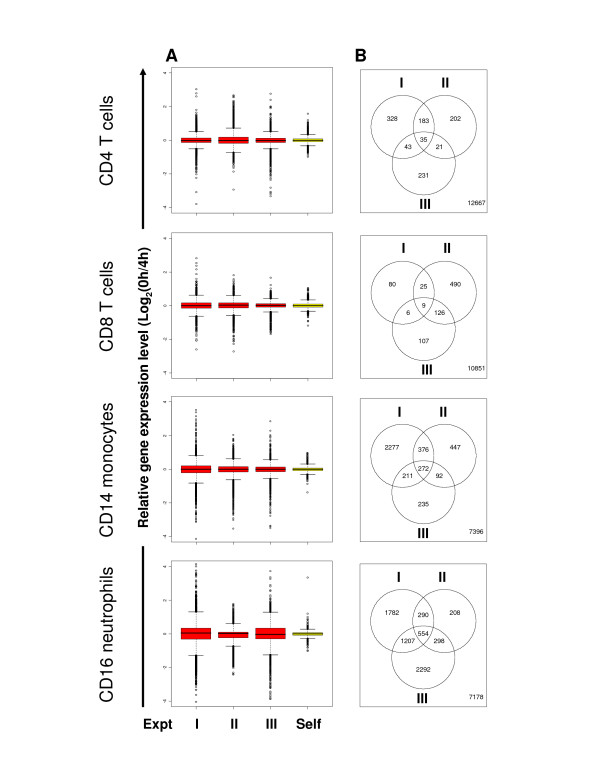
Delaying separation leads to significant changes in gene expression especially in cells of the myeloid lineage. Expression profiles were obtained from RNA samples extracted from cells separated immediately following venesection compared to those separated after a four hour delay on ice. Box plots (A) show the change in gene expression between 0 and 4 hours for independent experiments (I – III) and combined self versus self hybridisation data. The Venn diagrams (B) show the number and overlap between genes showing statistically significant differential expression (as defined in the materials and methods).